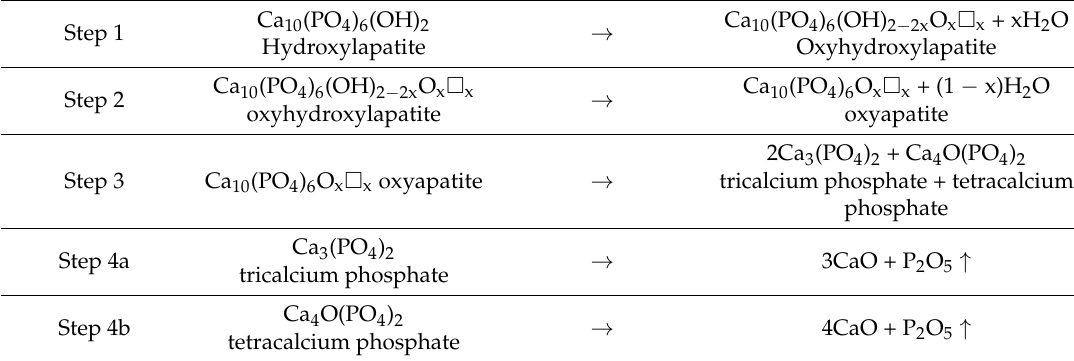
Table 2. Thermal decomposition sequence of plasma-sprayed hydroxylapatite.